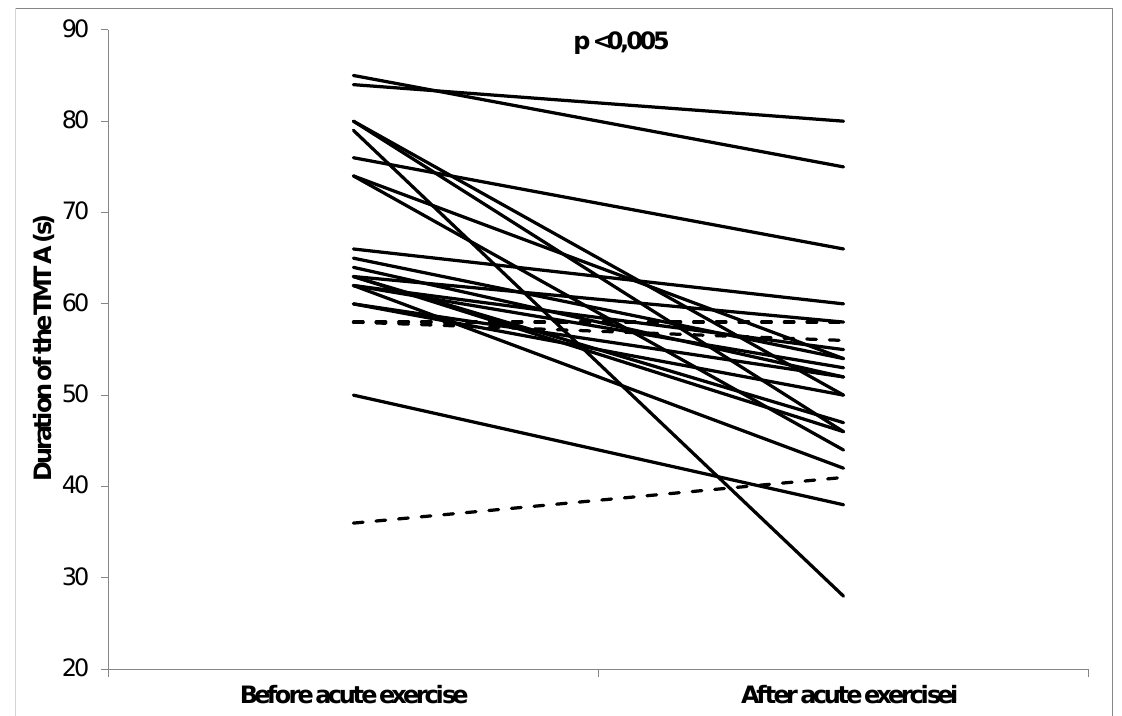
Fig.3. Individual scores in the Trial Making Test – duration of the TMT A phase. Each subject’s results from before and after acute exercise are connected by a line. Solid line depicts subjects who fared better on the post-exercise test, dashed lines those who fared worse after physical exercise.